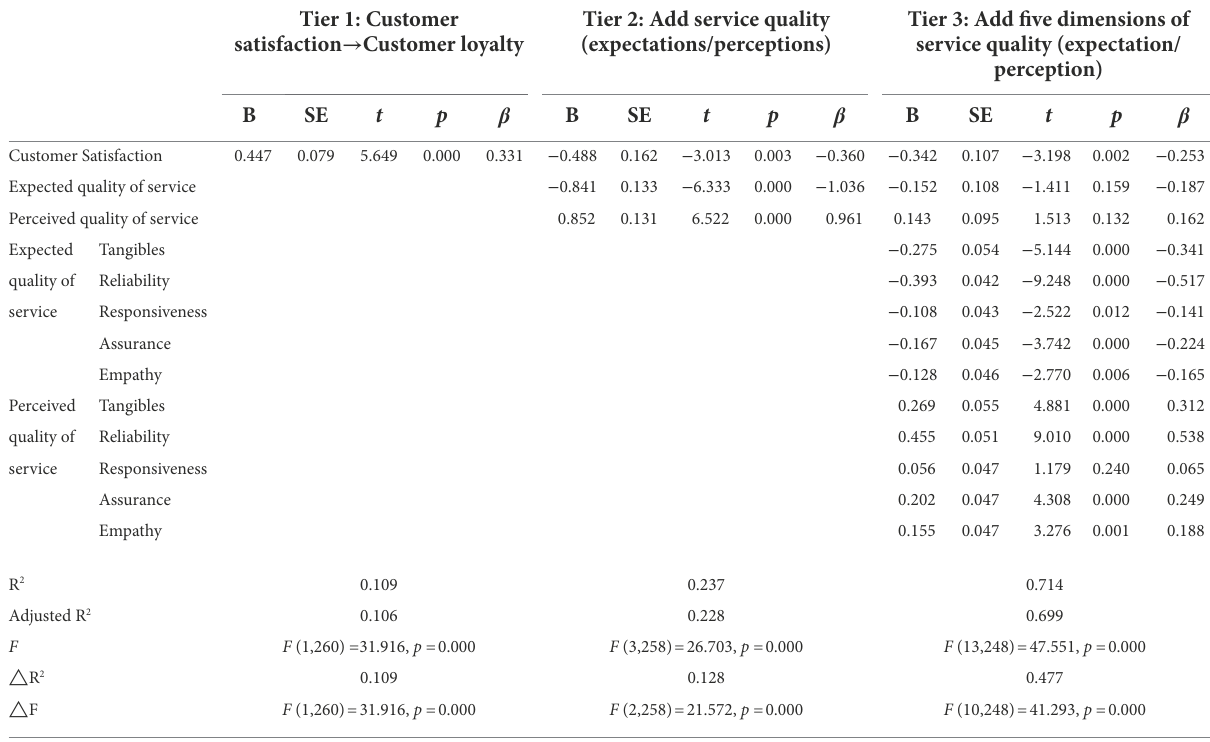
TABLE 8 Results of stratified regression analysis. Tier 1: Customer satisfaction → Customer loyalty